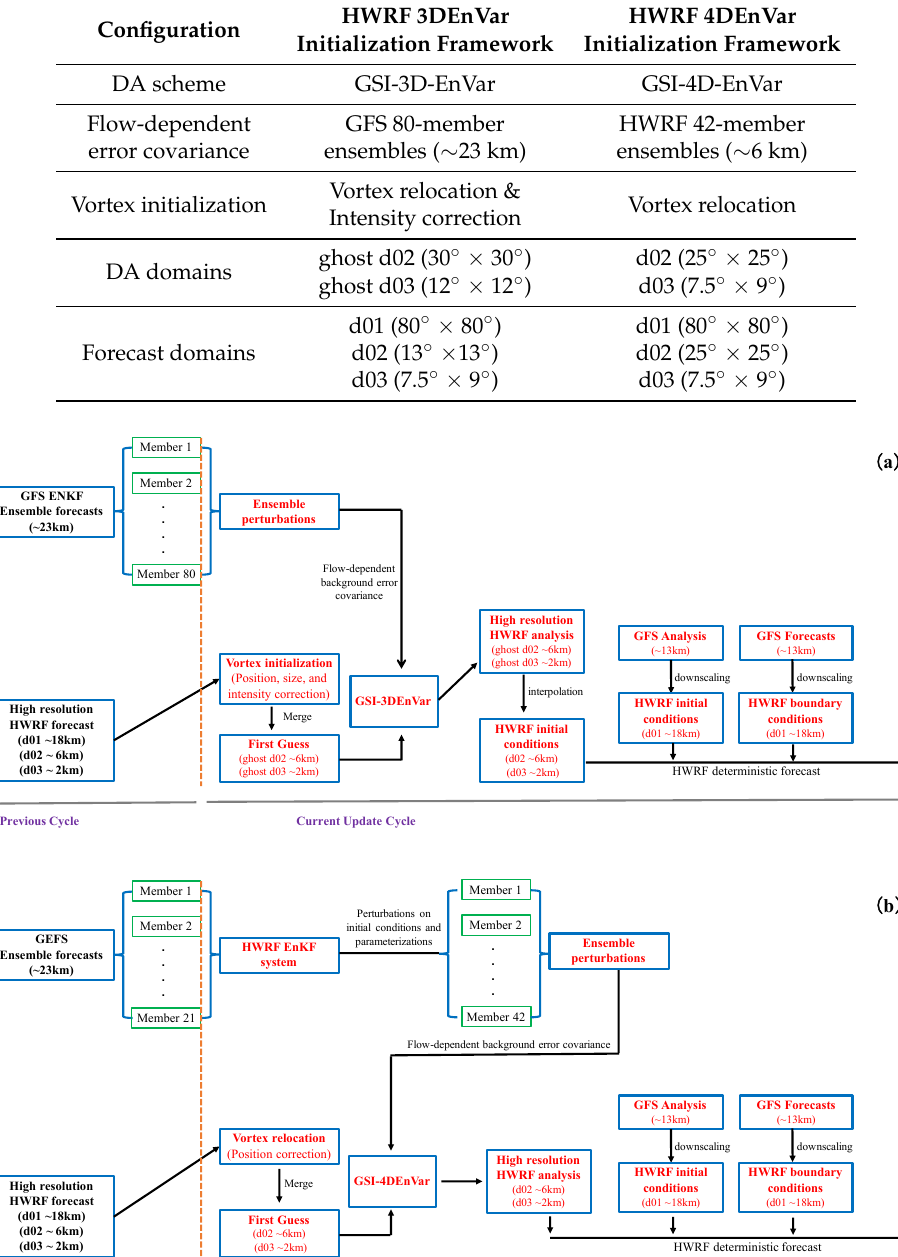
Table 1. Differences between the three-dimensional ensemble-variational (3DEnVar) and the four-dimensional ensemble-variational (4DEnVar) initialization frameworks for Hurricane Weather Research and Forecasting (HWRF).